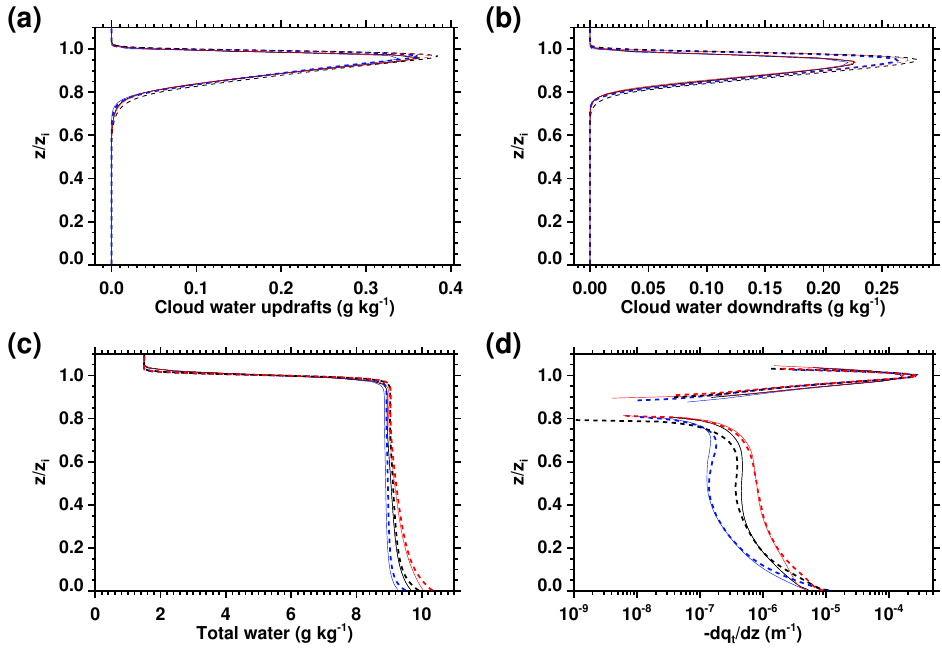
Figure C8. Effect of resolution. Profiles averaged over 1h in the period C (22:30–23:30UT) from simulations M − (blue), M 0 (black), M + (red), solid curves, and from simulations M −